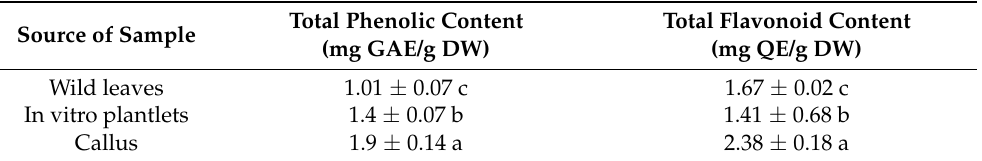
Table 5. Total phenolic and flavonoid content of different samples of Labisia pumila var. alata aqueous